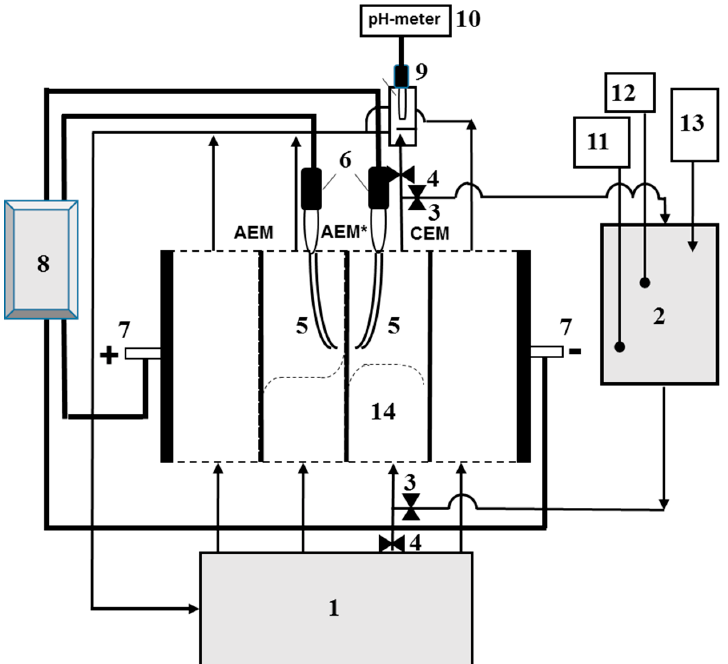
Figure 8. Schematic design of the setup used for determining the mass transfer and electrochemical characteristics of the cation-exchange membrane (CEM) and anion-exchange membrane (AEM) forming the desalination compartment (14). The setup included: an intermediate feed tank (1); an additional tank (2) for maintaining a constant pH; valves (3, 4); Luggin capillaries (5) connected with measuring Ag / AgCl electrodes (6); platinum polarizing electrodes (7); an electrochemical complex (an Autolab PGSTAT-100) (8); a flow cell (9) with an immersed combined electrode for pH measurement; a pH meter (10) connected to a computer; a combined electrode for pH measurement (11) connected to a pH meter; a conductivity cell (12) connected to a conductometer; a device (13) for maintaining a constant pH in the solution circulating through tank (2); AEM * is the anion-exchange membranes under study; CEM and AEM are the auxiliary membranes. The dotted lines schematically show the counterion concentration profiles in the cell